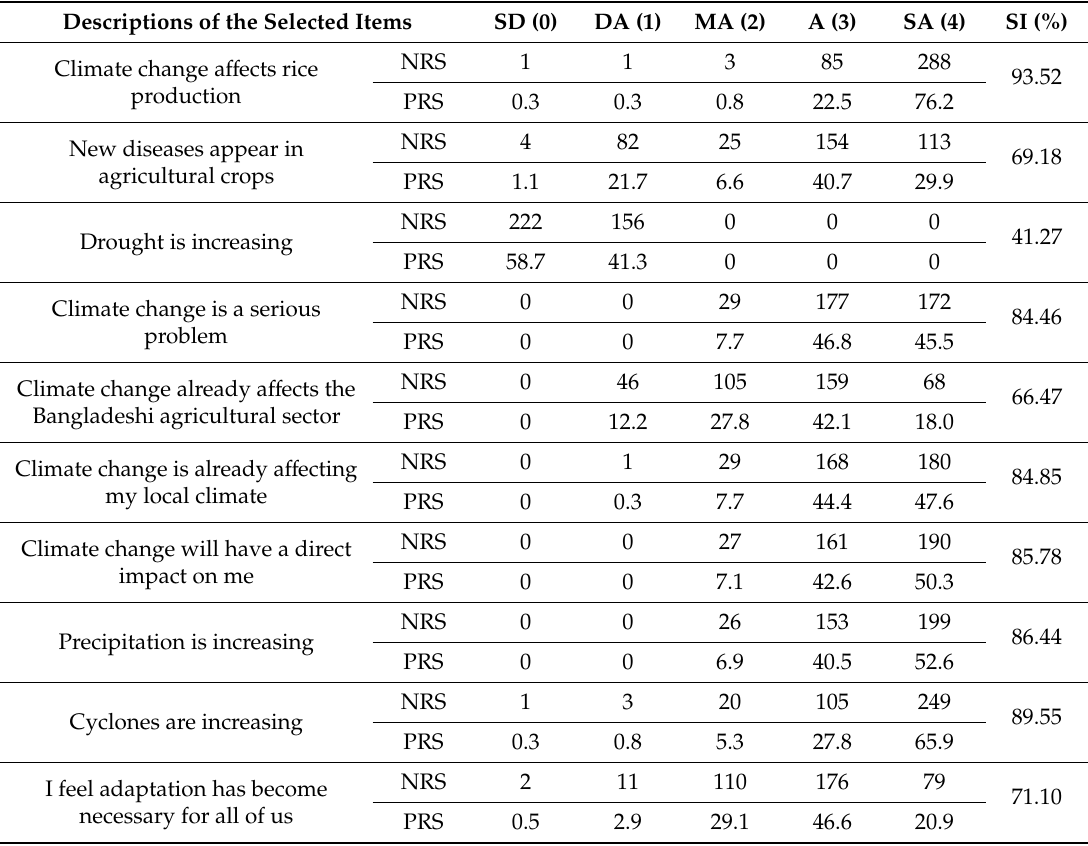
Table 1. Farmers’ perceptions and attitudes with respect to climate change